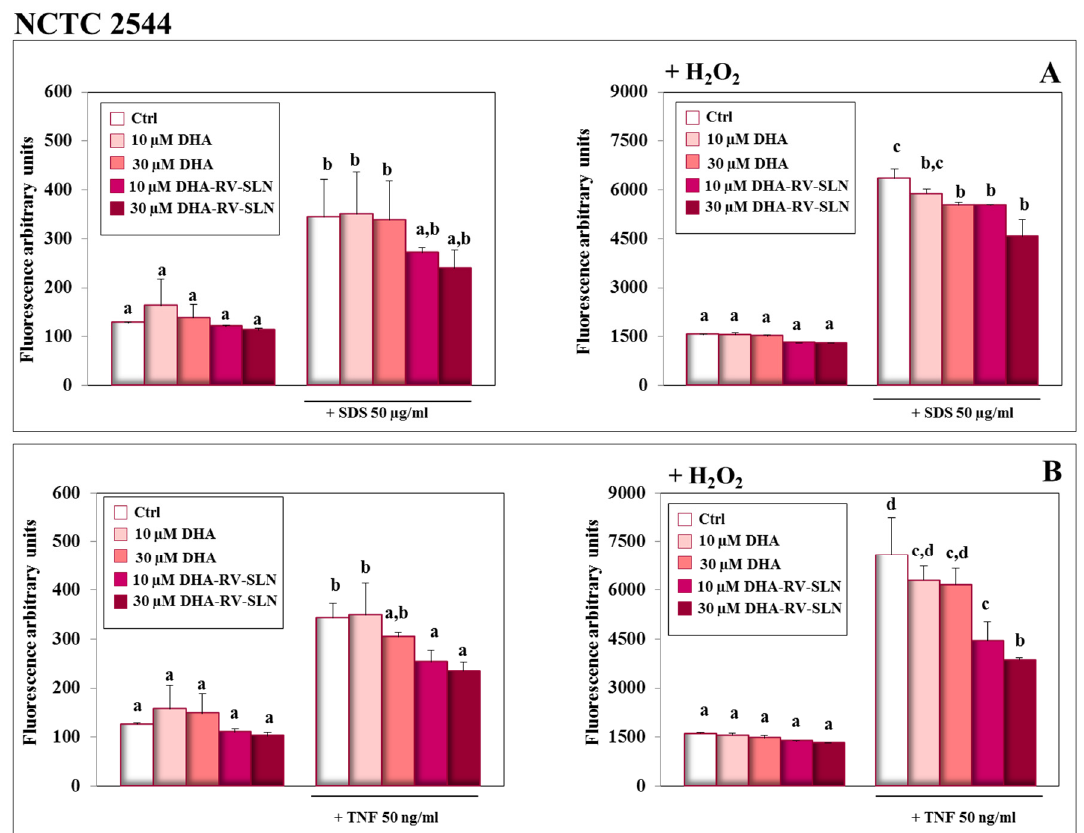
Figure 6. Effect of free DHA and DHA-RV-SLNs on ROS production in NCTC 2544 keratinocytes treated with SDS or TNF- α . The cells were treated with free DHA or DHA-RV-SLNs (10 or 30 μ M) in the absence or in the presence of 50 μ g/mL SDS ( A ) or 50 ng/mL TNF- α ( B ) for 24 h, in basal conditions (left panels) or in the presence of 100 μ M H 2 O 2 as a pro-oxidant stimulus (right panels). Data are the means ± SD of three different experiments. Values not sharing the same superscript letter are significantly different ( p < 0.05, one-way ANOVA followed by Tukey’s test).